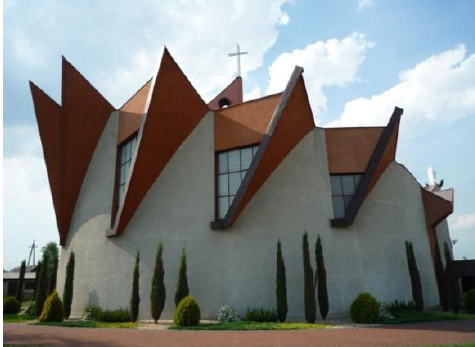
Figure 7. Church of Divine Providence in Krascice (built in 1991–98). Figure 8. Church of St. Thomas Apostol in Osiny (built in 1990–1991). 5. The Largest Churches of the Archdiocese of Częstochowa One of the many negative effects of the restrictions on obtaining permission to build churches was the fact that when a building permit was finally obtained, church authori- ties decided to build a very large building because the prospect of obtaining another permit was uncertain. Sacral buildings were designed with a usable area exceeding 1000 m 2 and even 1500 m 2 . Most of these structures were built between 1984–1992 (in 1988 in the whole of Poland, 173 churches, with an area of over 1500 m 2 and 66 churches with an area of more than 1000 m 2 were built) (Cichońska et al. 2016). A fall in the number of very large structures was not recorded until 2000. Most of these churches are now too large for the actual needs of their parishes, which have a much smaller territory. Territorially large parishes have been divided into several smaller ones, each with their own church. Due to the smaller number of parish-